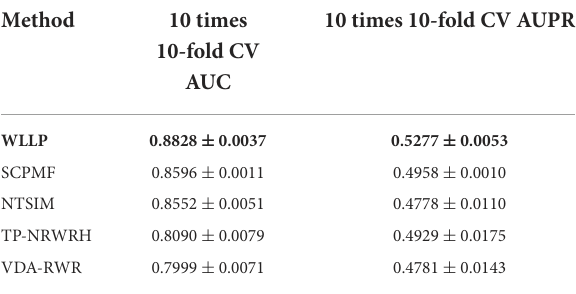
TABLE 1 Performances of the five prediction methods on the human drug virus database (HDVD)